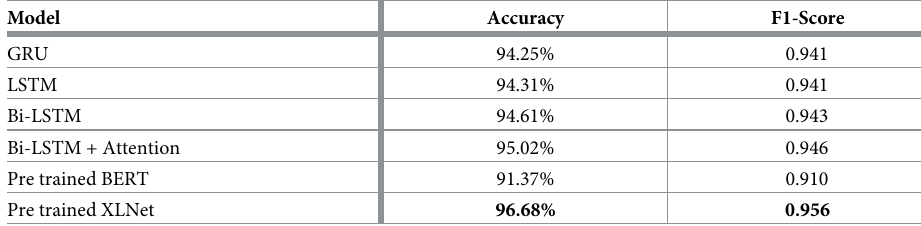
Table 6. Results of different models for sentiment